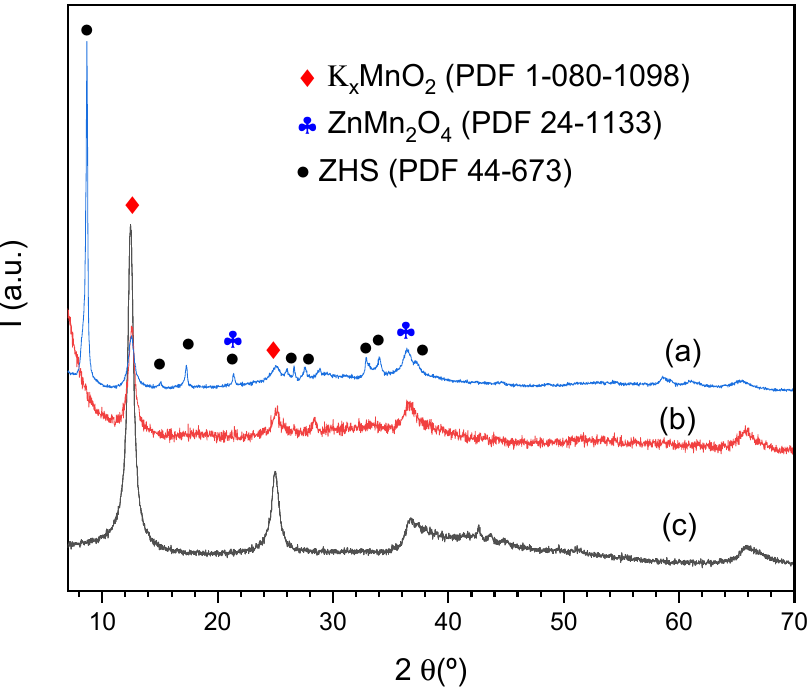
Figure 8. XRD profile “ex situ” of KMn4 after three cycles (a) discharged (b) charged (c) KMn4 profile with comparative purpose.